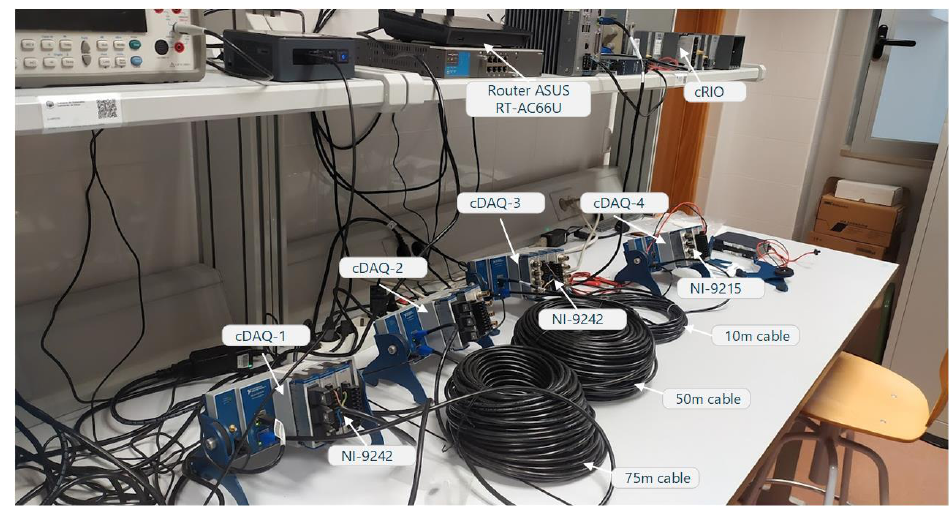
Figure 16. The four cDAQs connected in-line with 50 m, 75 m, and 10 m cables.